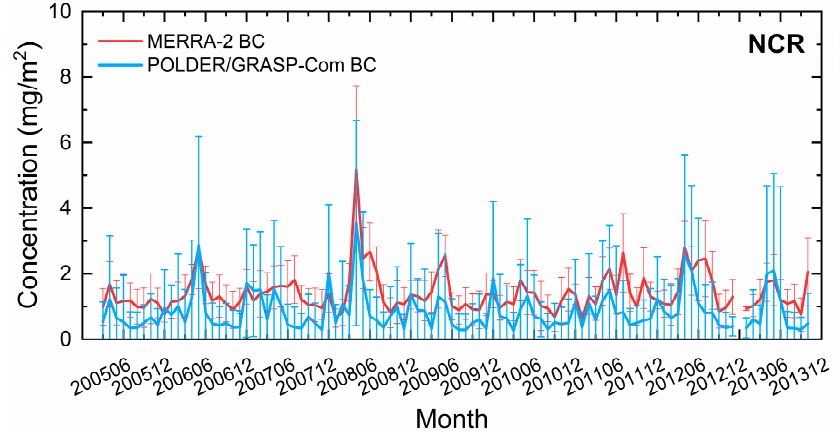
Figure 18. Same as Figure 13, but for Northeast China and east of Russia (NCR) region.